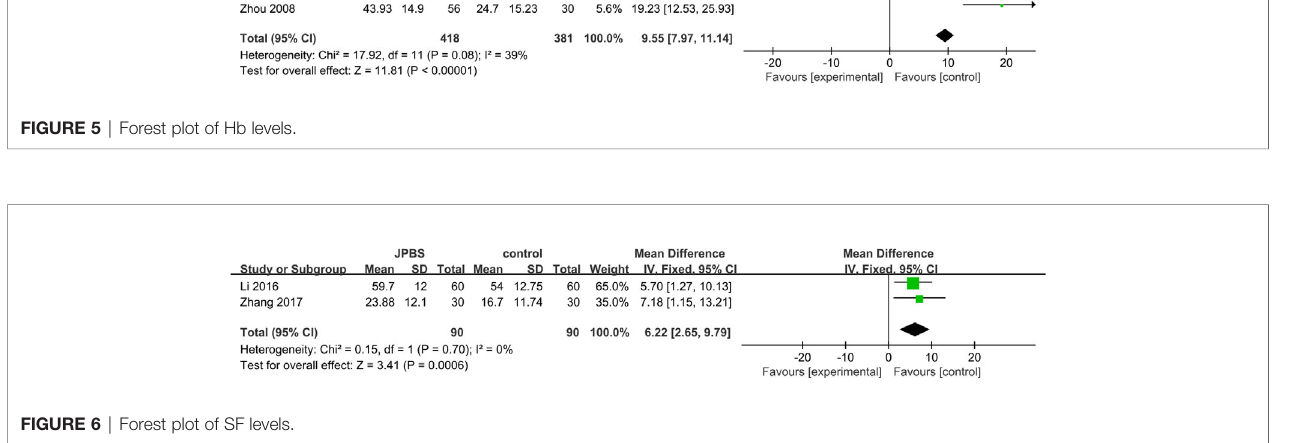
FIGURE 6 | Forest plot of SF levels.